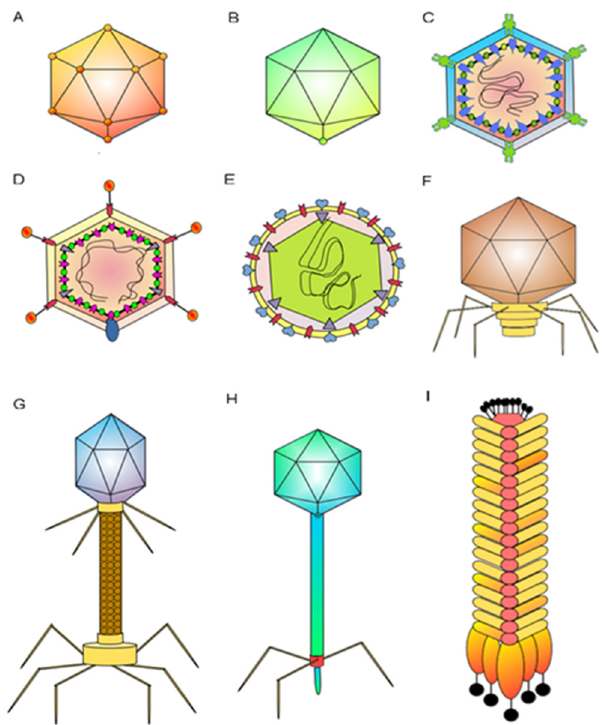
Figure 1. Schematic representation of the most commonly studied phages [16]: ( A ) levivirus MS2 has a capsid with icosahedral symmetry and a size of about 26 nm; ( B ) microvirus φ X174 is a non-evolved icosahedral capsid about 30 nm in size; ( C ) podovirus T7 is a non-evolved icosahedral capsid about 60 nm in size; ( D ) tectivirus PRD1 is a non-enveloped icosahedral capsid with a size of about 66 nm; ( E ) cystovirus phi6 is an enveloped spherical virion 85 nm in diameter; outer and inner capsids have icosahedral symmetry; ( F ) corticovirusPM2 is an icosahedral capsid 56 nm in diameter; ( G ) myovirus T4 is non-enveloped, with a morphological head–tail structure about 110 nm in length; ( H ) siphovirus T5 is non-enveloped, with a head–tail structure; head is about 60 nm in diameter; and ( I ) inovirus M13 is non-enveloped, with rods of filaments 7 nm in diameter and 700 to 2000 nm in length.